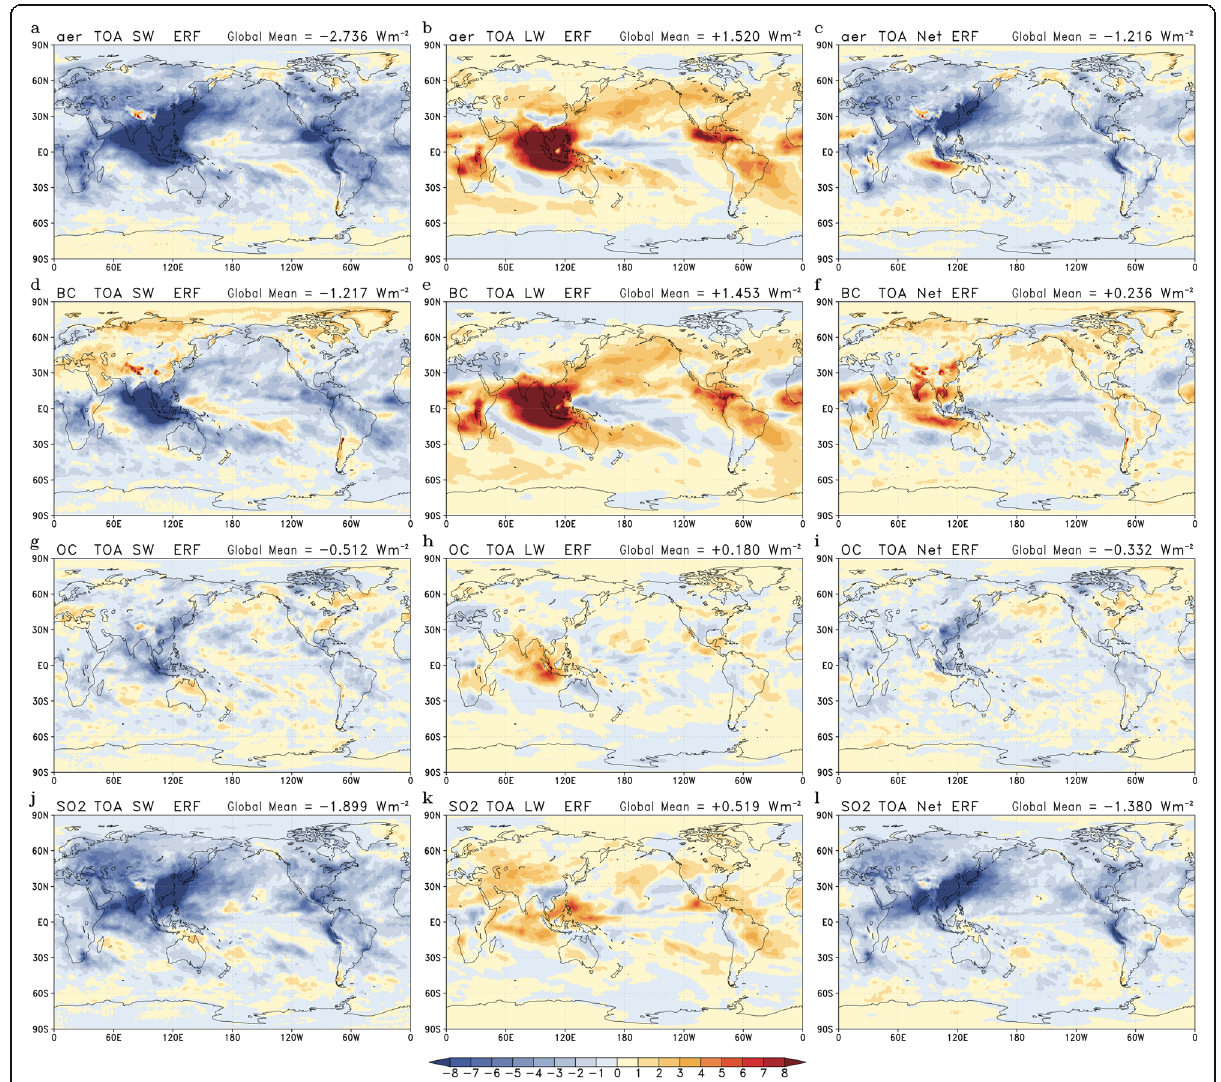
Fig. 3 Horizontal distributions of the annual mean ERFs (W m − 2 , filled contours) at the TOA for shortwave (SW, left); longwave (LW, middle); and their sum (net, right) in the ( a – c ) piClim-aer (aer); ( d – f ) piClim-BC (BC); ( g – i ) piClim-OC (OC); and ( j – l ) piClim-SO2 (SO2) experiments in MRI- ESM2.0. The global mean ERF values are shown near the upper-right corner of each panel and are given in Table